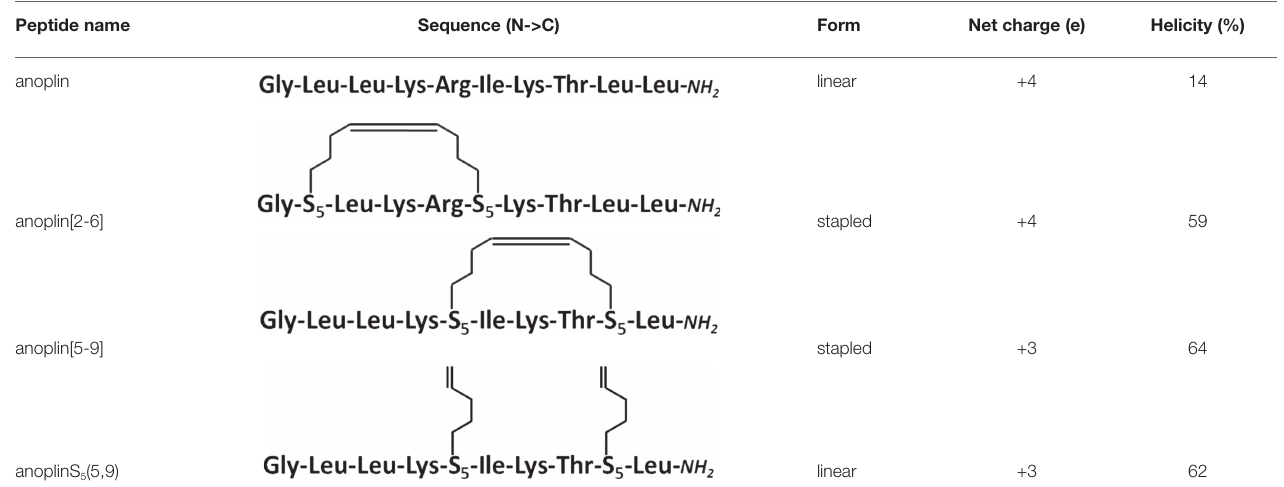
TABLE 1 | Peptide sequence modifications form, net charge at pH 7.4, percentage of helicity calculated from the CD spectra of peptides in the phosphate buffer, determined using the DichroWeb software (Whitmore and Wallace, 2004); all peptides have an amide at the C-terminus. Peptide